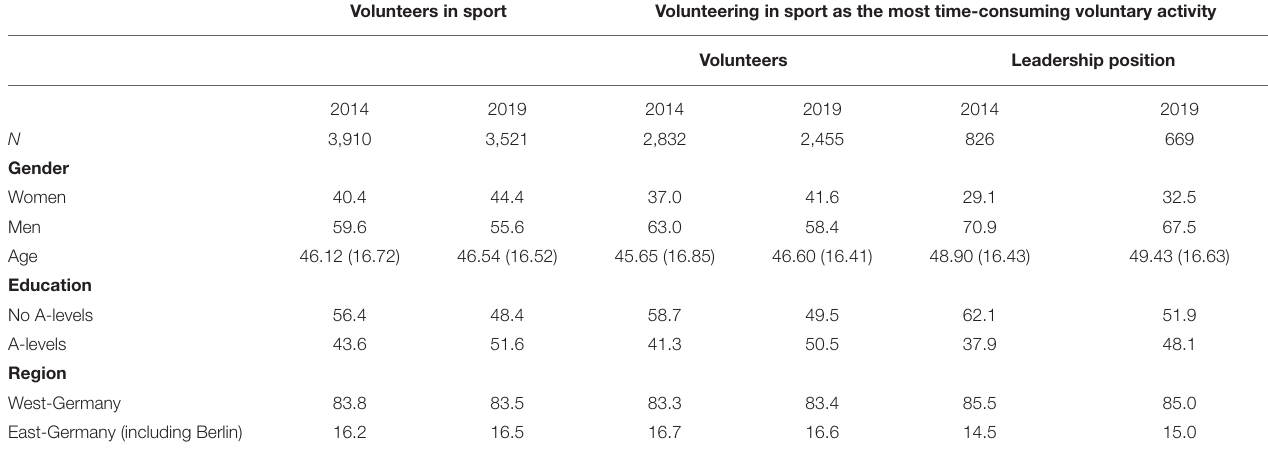
TABLE 3 | Description of the subsample sport